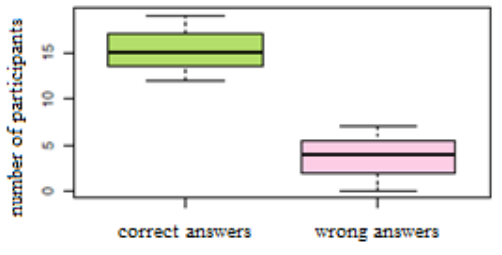
Figure 3 . Boxplot for familiarization sentences